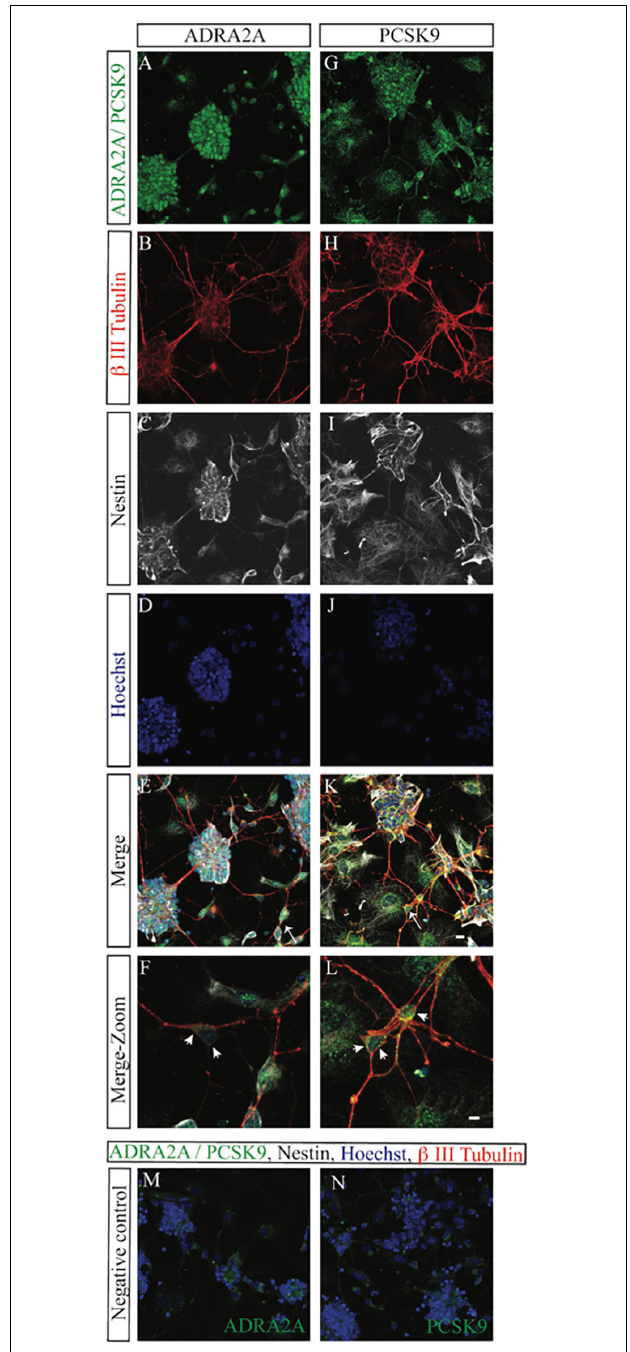
FIGURE 3 | Immunocytochemistry of ADRA2A and PCSK9 levels in control (untreated) primary mouse retinal cells on day 7. Representative confocal LSM images of primary mouse retinal cultures at day 7 showing expression of ADRA2A (A) , β III tubulin (B) , Nestin (C) , cell nuclei (Hoechst), (D) a merge image (E) , and a zoomed merge image (F) . (G–L) LSM images of primary mouse retinal cultures at day 7 showing expression of PCSK9 (G) , β III tubulin (H) , Nestin (I) , cell nuclei (Hoechst) (J) , a merge image (K) and a zoomed merge image (L) . (M,N) Negative controls were treated without primary antibody and are shown as merge images. Scale bar = 10 µ m or scale bar = 5 µ m for zoomed